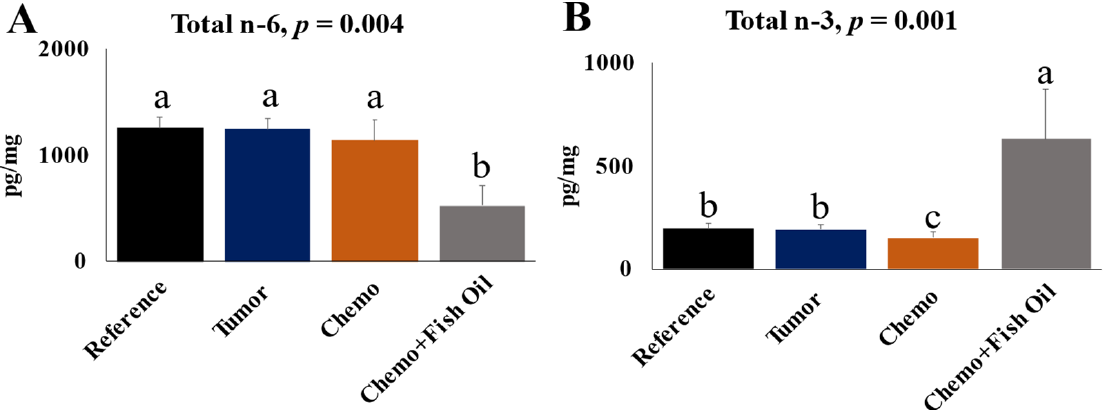
Figure 4. Liver total n-6 oxylipins ( A ); total n-3 oxylipins ( B ). Values are means ± SD, n = 6. Significant differences ( p < 0.05) were determined using one-way ANOVA. Post hoc analysis was carried out Kruskal–Wallis test indicated the presence of differences. Differing lower-case superscript letters